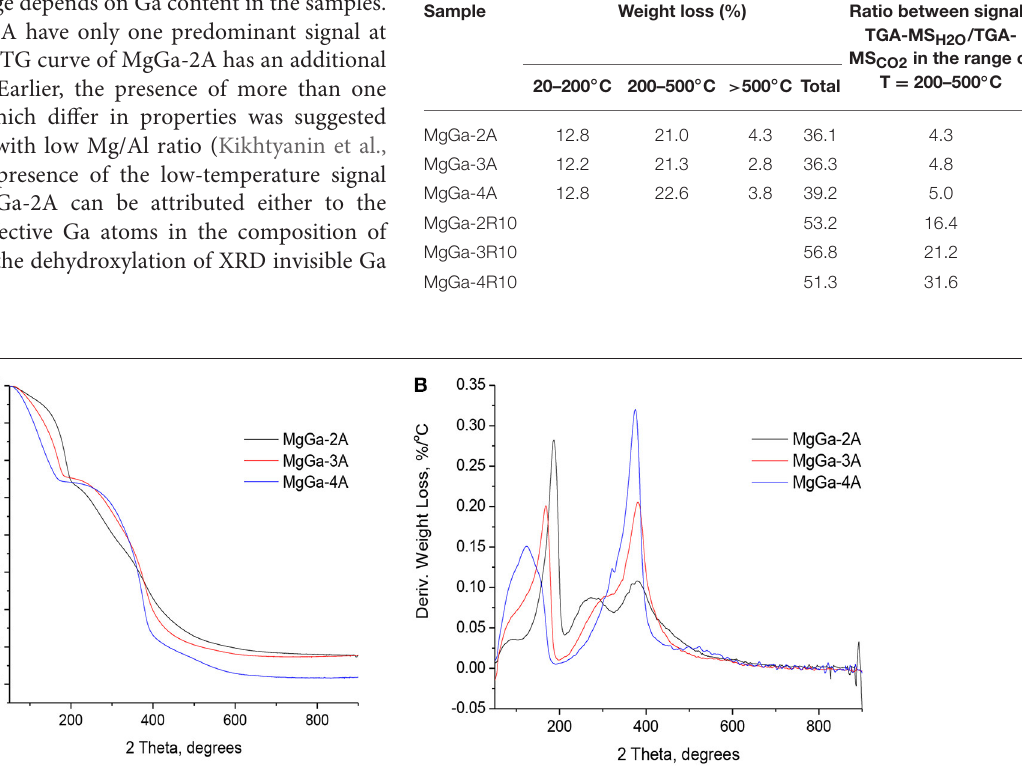
FIGURE 3 | TGA (A) and DTG (B) curves of as-prepared MgGa hydrotalcites.